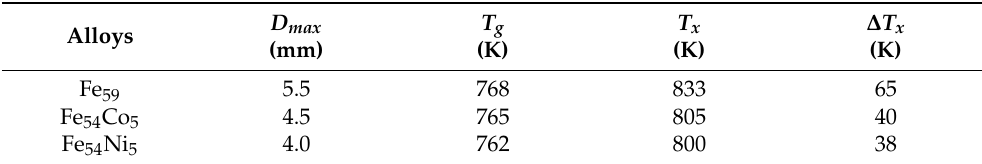
Figure 1. ( a ) XRD patterns and ( b ) DSC curves of as-prepared Fe 54 M 5 Cr 15 Mo 6 Si 2 B 4 P 10 C 4 (M = Fe, Ni, and Co) glassy alloy rods with the critical diameter ( D max ) for glass formation. Photos of ( c ) Fe 59 , ( d ) Fe 54 Co 5 , and ( e ) Fe 54 Ni 5 glassy alloy rods with the D max values. Table 1. Summary of the critical diameters for glass formation ( D max ), thermal properties, and the the DSC curves at a heating rate of 0.33 K/s ( T g : glass transition temperature, T x : onset crystallization temperature, ∆ T x = T x − T g ).